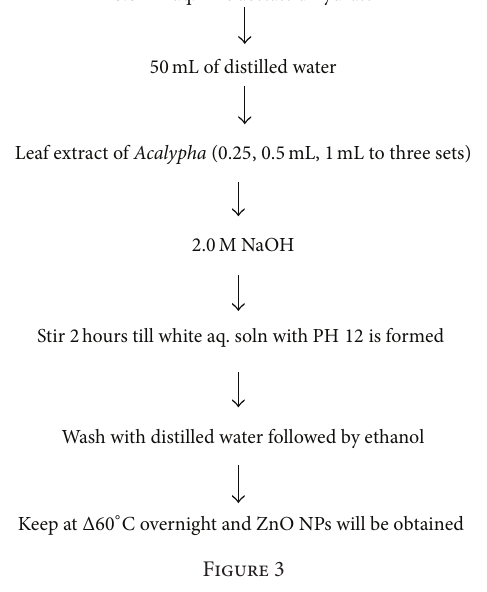
Table 1: Physical properties of wurtzite zinc oxide nanoparticles